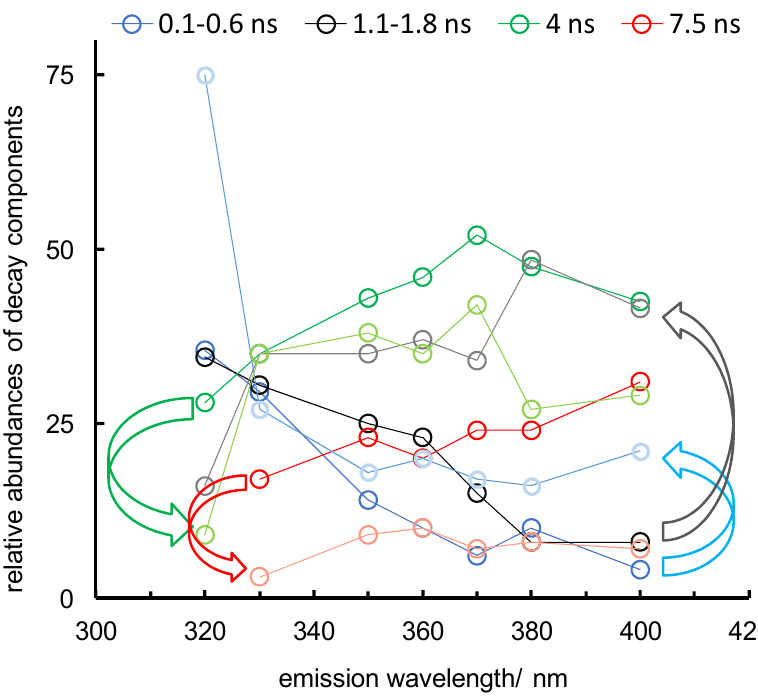
Figure 5. Effects of the addition of 0.1 M KI on the emission decays of Lm PTR1 at different emission wavelengths. Curved arrows and fading of colours of circles and lines indicate changes in the relative abundances (expressed as %) of the four decay components following iodide addition. λ exc = 285 nm.